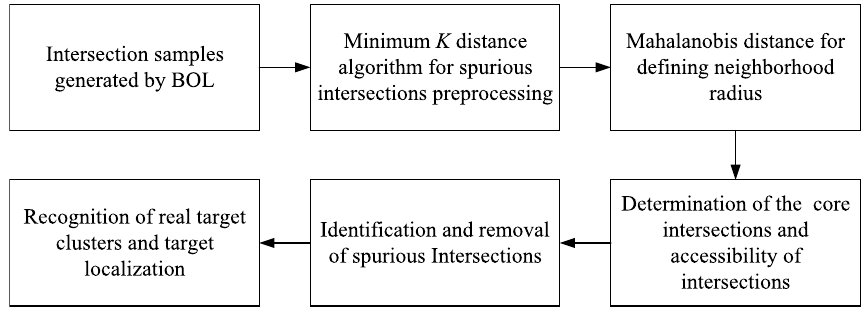
Fig. 1 Overview of the proposed K-M-DBSCAN method for removal of spurious